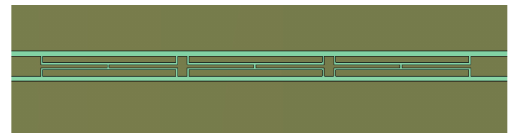
Figure 13: Top view of bandpass structure achieved by cascading three cells of DS-UC.